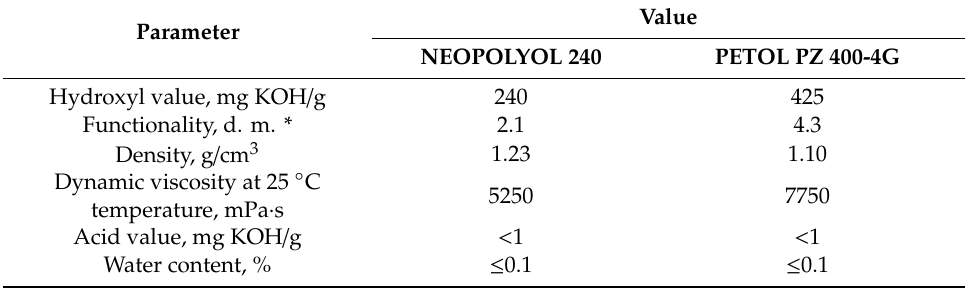
Table 2. Basic chemical characteristics of polyols used in the production of rigid polyurethane foams.